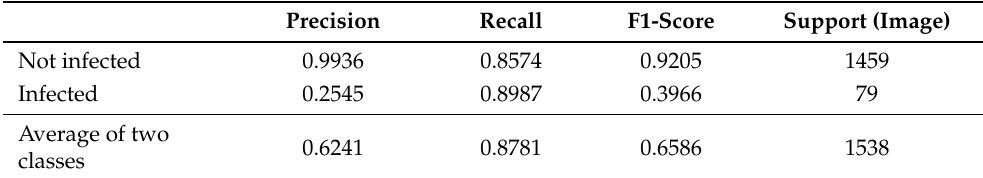
Table 10. Performance of the model in external dataset-2 for both classes.